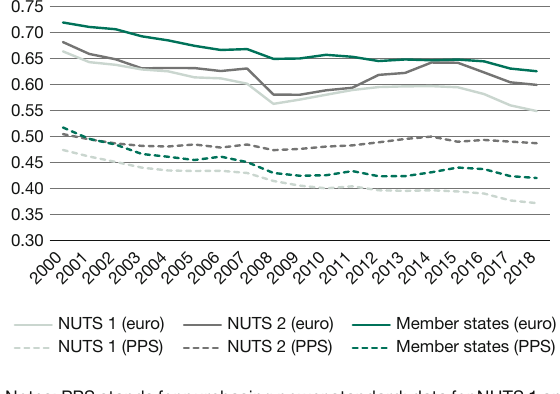
Figure 1 Standard deviation of per capita incomes in the EU28, 2000-2019 in euros